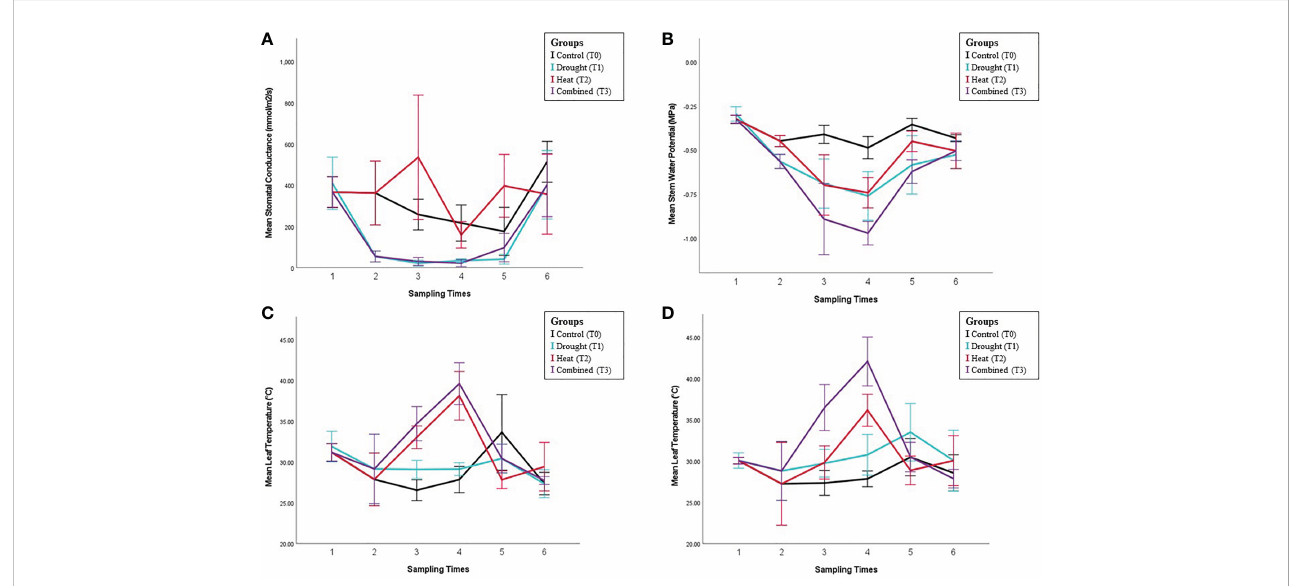
FIGURE 1 Physiological analysis results under different stress conditions. Panels show collected physiological measurements for (A) Stomatal conductance (g s ). (B) Stem water potential (Stem Y ). (C) Leaf temperature (LT) of the third young leaf (not fully expanded), and the fi rst fully expanded leaf (D) . Error bars indicate the standard error of means (n =